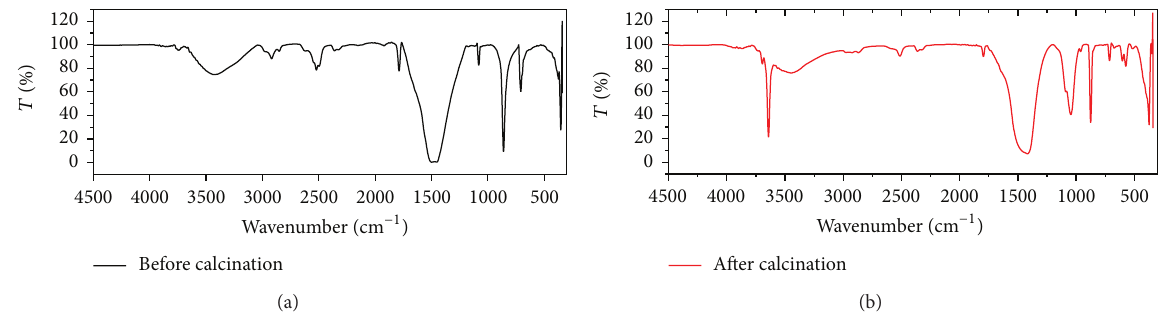
Figure 2: FTIR spectra of crab shells (a) before calcinations and (b) after calcinations at a temperature 1000 ∘ C for 5